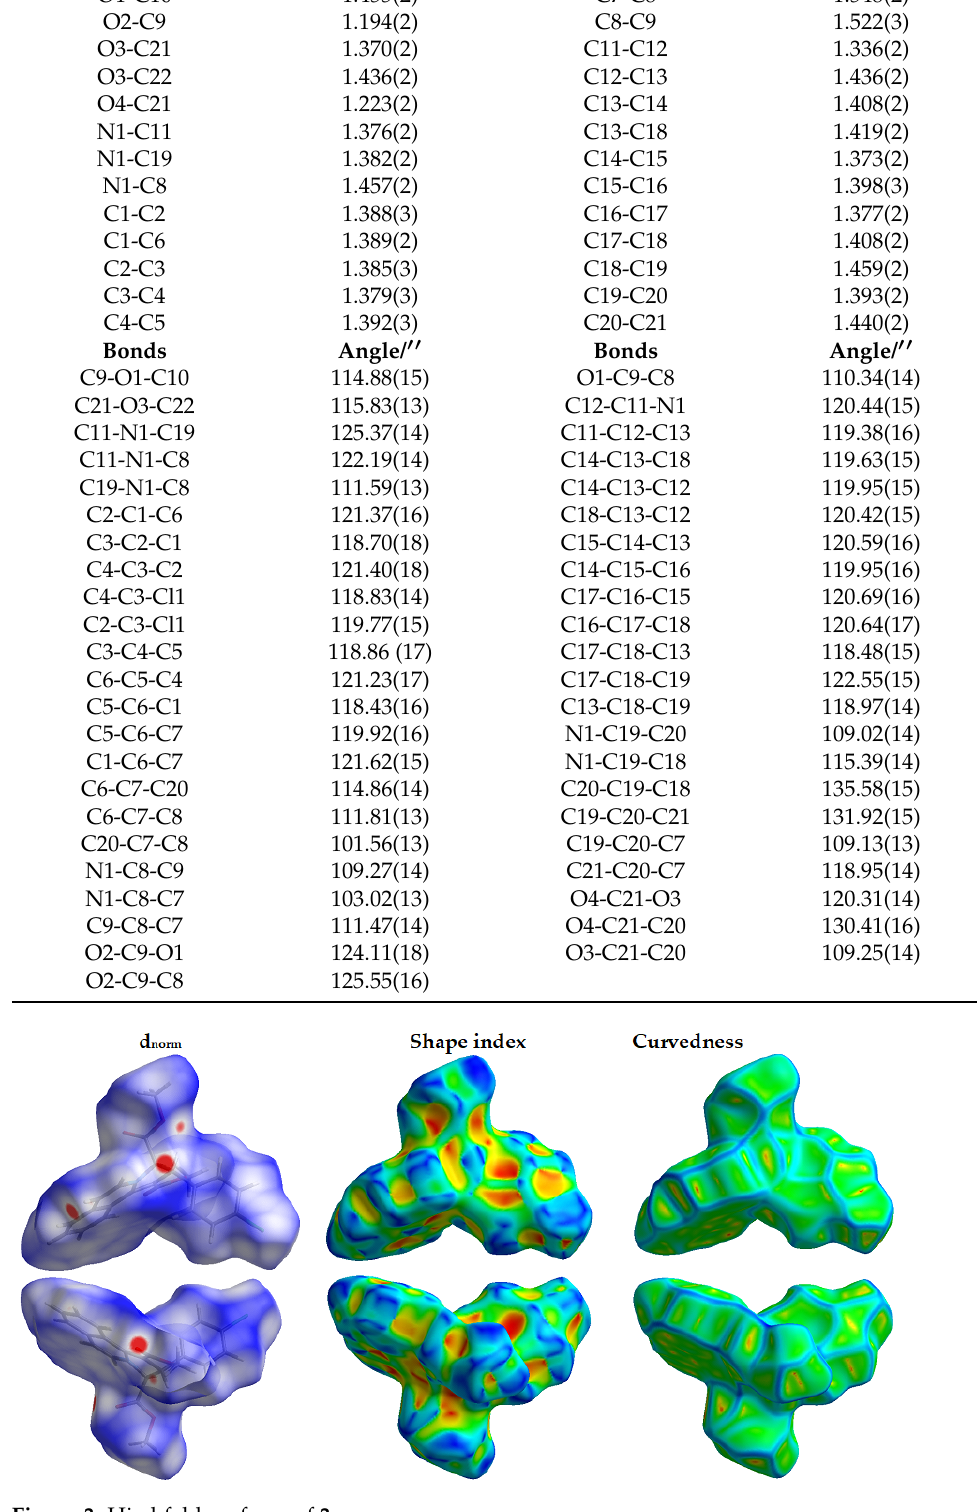
Figure 3. Hirshfeld surfaces of 3 .